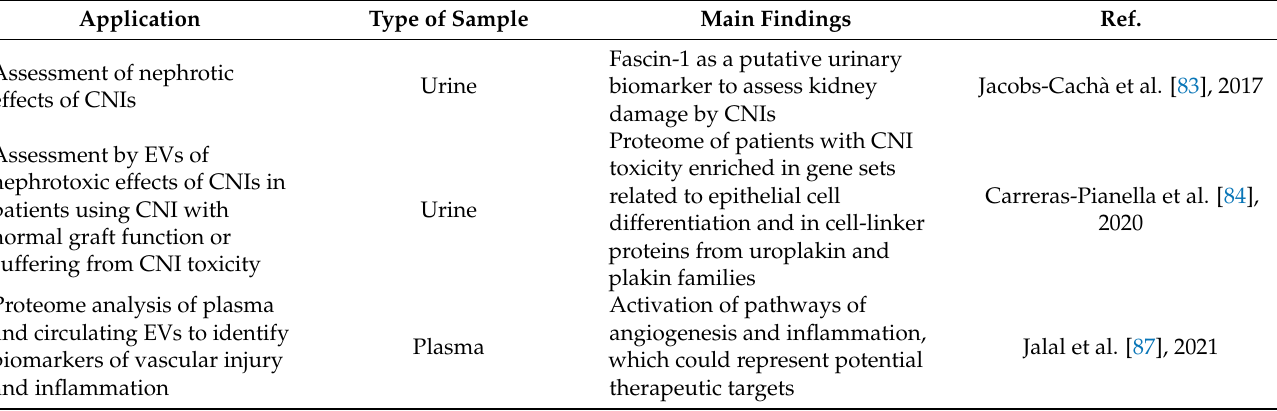
Table 7. Miscellaneous recent proteomic studies in the setting of kidney